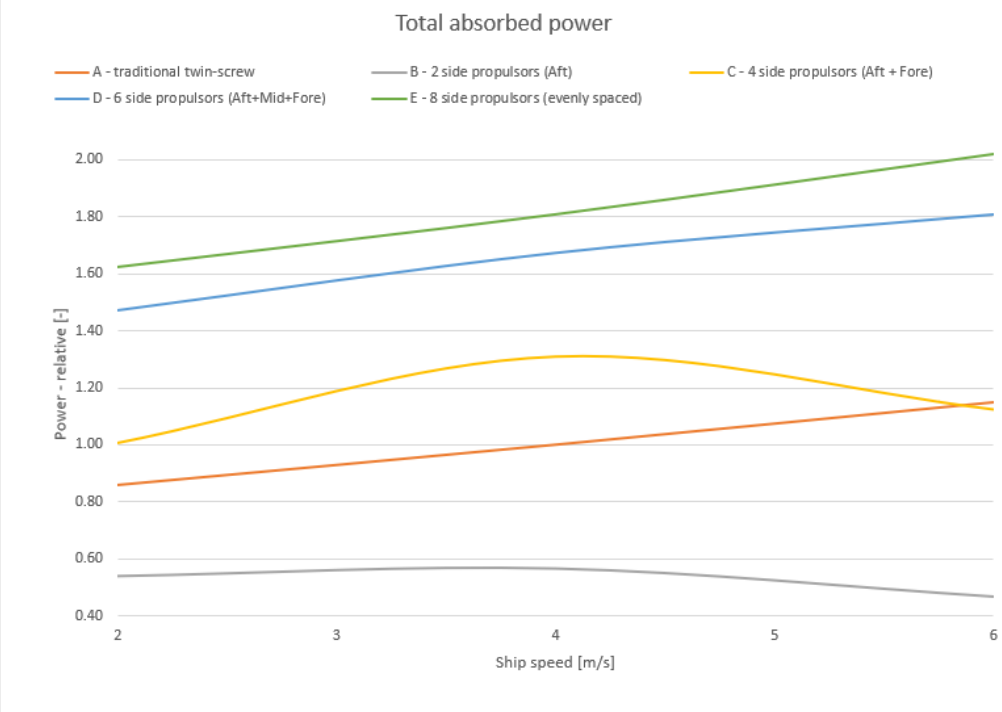
Figure 11. Total absorbed power, shallow water (comparison). Source: Authors. Rapid changes and some problematic areas can be identified easily in these graphs. In general, a significant fall in performance indicates intensive air intake into the propulsor. The occurrence of such ventilation can be checked visually in the graphical output from the CFD analysis.